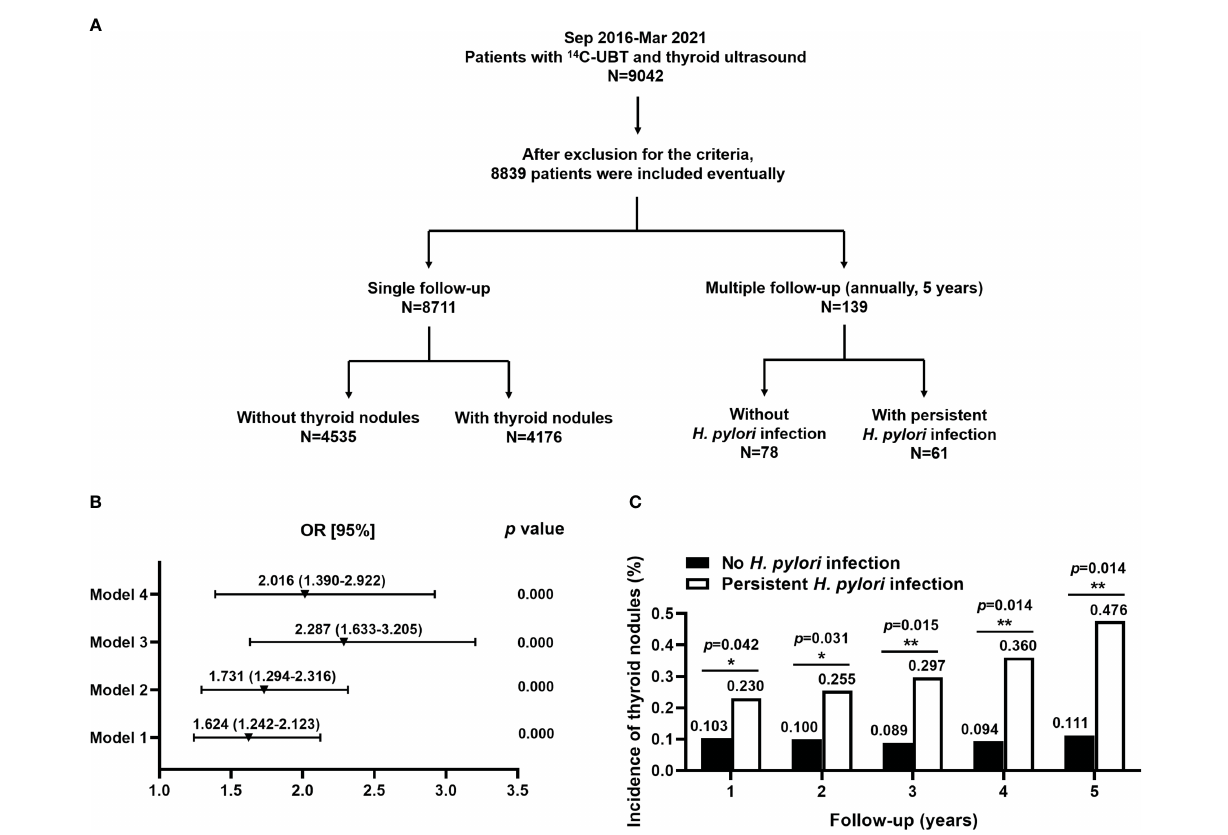
FIGURE 1 The basic study design and association between ( H ) pylori infection and the risk for TNs. (A) The basic design fl owchart for the study was divided into 2 parts: the single follow-up and multiple follow-ups. A cross-sectional study of single follow-up ( n =8,711) and a retrospective cohort study of multiple follow-ups ( n =139) were performed, respectively. (B) H . pylori was an independent risk factor for TNs. Model 1: unadjusted; Model 2: adjusted for age, gender, alcohol, seafood consumption habit, WHR, and SBP; Model 3: model 2 plus an adjustment for smoking, family history of thyroid disease, ALT, AST, HDL-C, and TCH; Model 4: model 3 plus an adjustment for BMI, DBP, FT3, FT4, anti-TPO, Tg, and rT3. (C) Persistent H . pylori infection signi fi cantly increased the risk of developing TNs at annual follow-up for 5